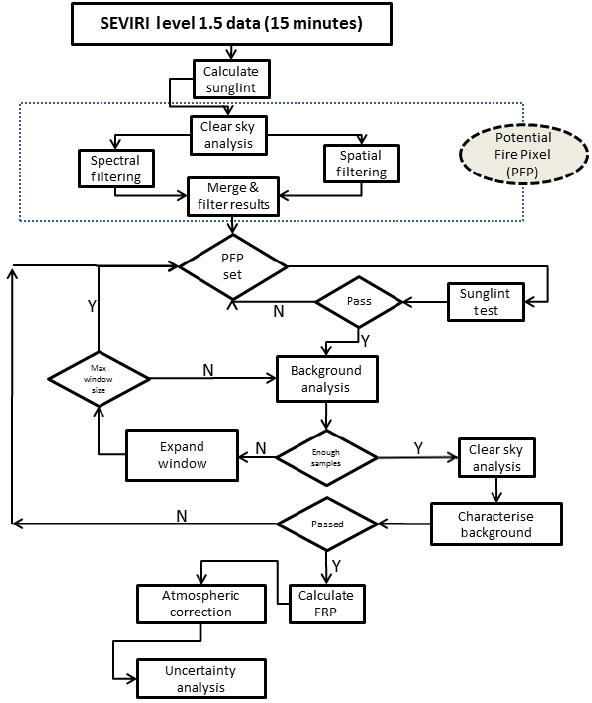
Figure 3. Flowchart illustrating the FRP-PIXEL product process- ing chain, which uses the operational geostationary FTA algorithm described herein. The processing chain acts upon the input level 1.5 data from each SEVIRI imaging slot independently, and the pro- cedures outlined by the blue dotted box are those involved in the selection of the potential fire pixels (PFPs). These PFPs are then subject to a series of thresholding procedures, based on spatially varying “contextual” thresholds, used to determine whether or not each FPF can be confirmed as a true active fire pixel and have its FRP